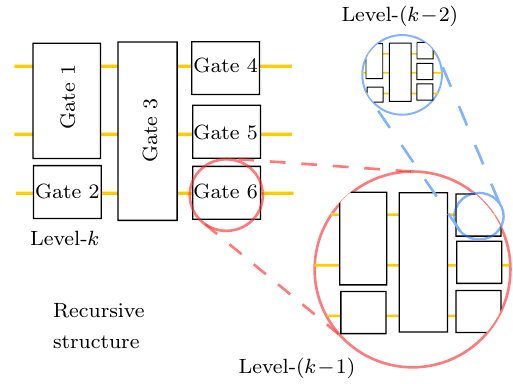
FIG. 2. The accuracy of a quantum computation can be increased by a FTQC scheme that makes use of concatenation and recursive simulation. Circuits are designed to be hierar- chical, with high-level gate components built from lower-level components in a self-similar